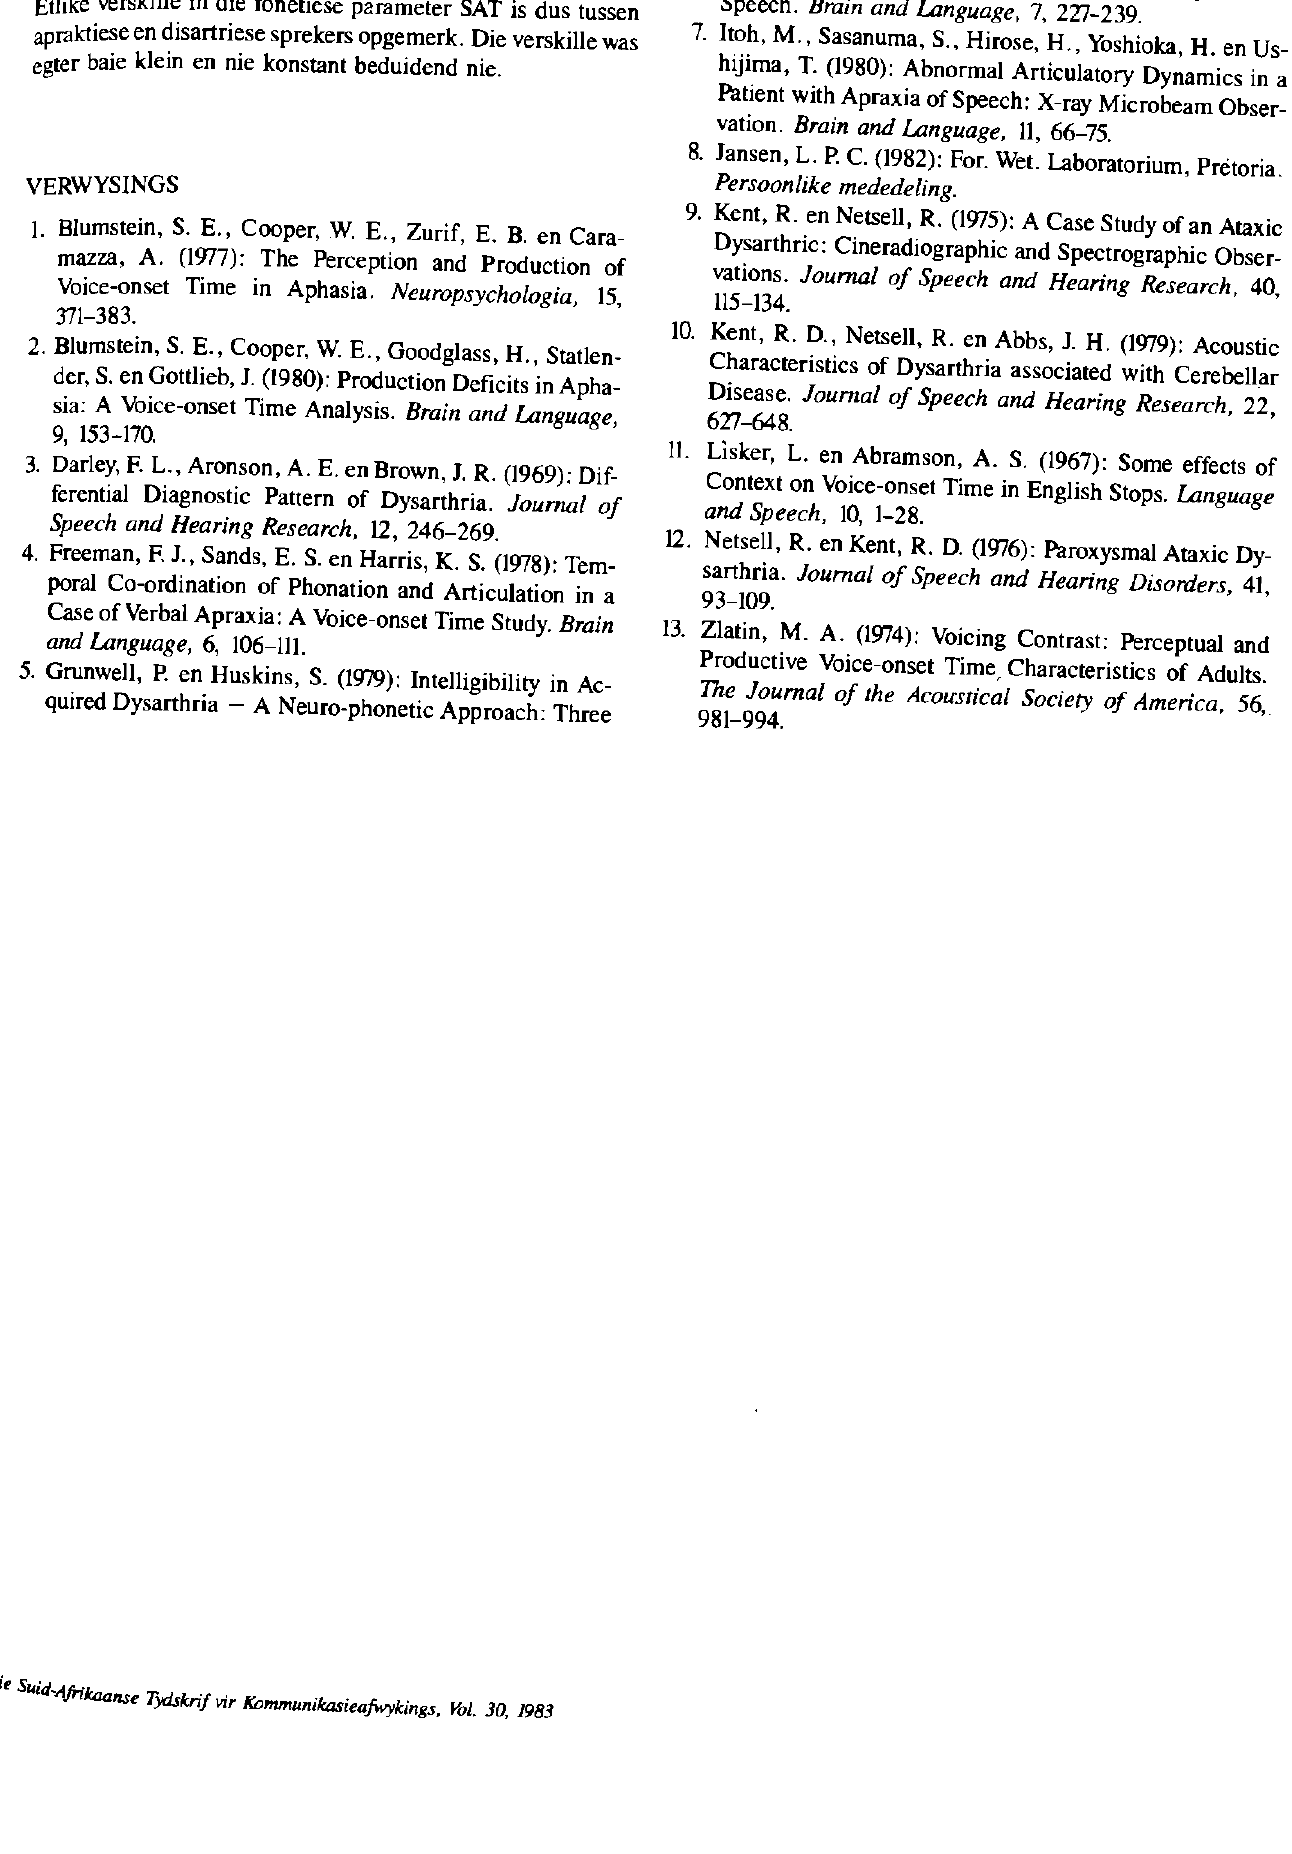
Die Stemaanvangstyd van Apraktiese en Disartriese Sprekers Die gemiddelde stemaanvangstye vir sowel die twee eksperi- mentele groepe as die kontrolegroep stem in so 'n mate ooreen dat daar nie vir elke groep 'n afsonderlike kenmerkende SAT bepaal kon word nie. Etlike verskille in die fonetiese parameter SAT is dus tussen apraktiese en disartriese sprekers opgemerk. Die verskille